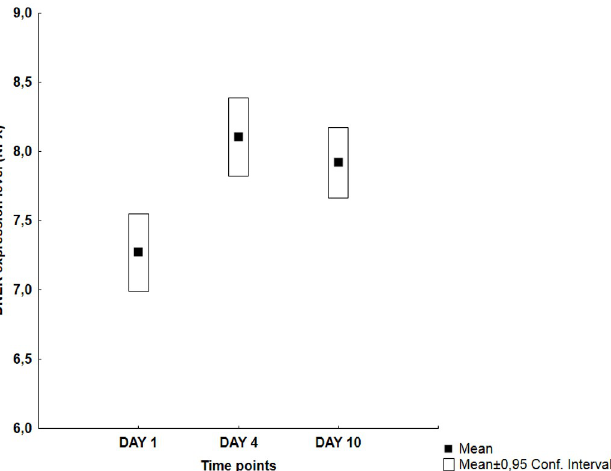
Fig 2. Group B example; DNER: Temporal pattern of protein expression level (mean NPX ± 0.95 CI) for Delta and Notch-like epidermal growth factor-related receptor (DNER). Statistically significant peak in the middle of the observation period defined by significantly higher day 4 vs day 1 (8,1 vs 7,27; p < 0.005) and day 4 vs day 10 mean NPX values (8,1 vs 7,92; p < 0.05).